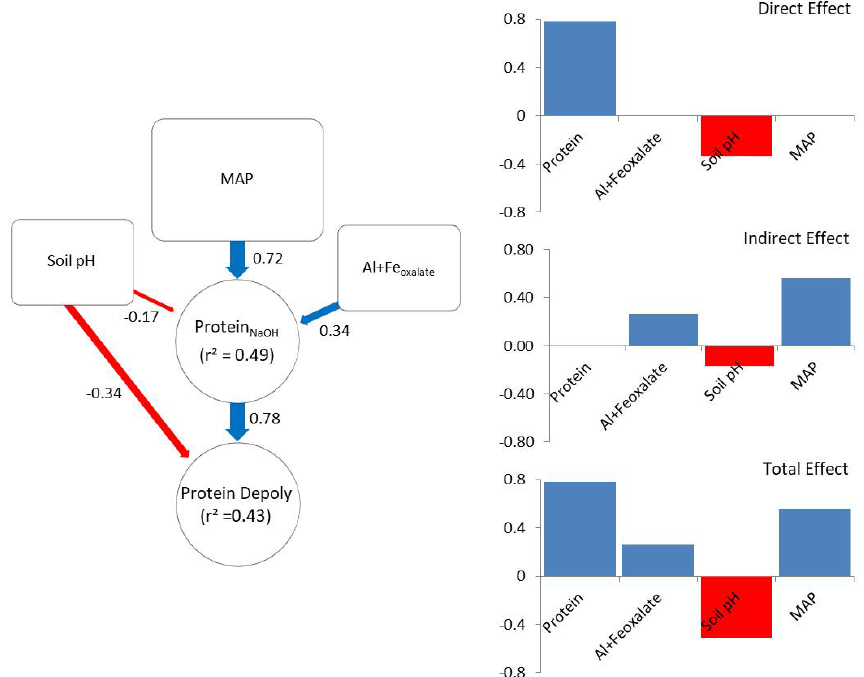
Figure 5. Direct and indirect effects in gross protein depolymerization rates. Controls of path analyses for gross protein depolymeriza- tion rates in mineral soils and coefficients for direct, indirect and total effects ( n = 91). Significant effects ( p < 0 . 05) are indicated by red (negative) and blue (positive) arrows. Effect sizes are indicated by line width. Numbers beside arrows indicate the standardized parameter estimates. Numbers within boxes indicate the variance explained by the